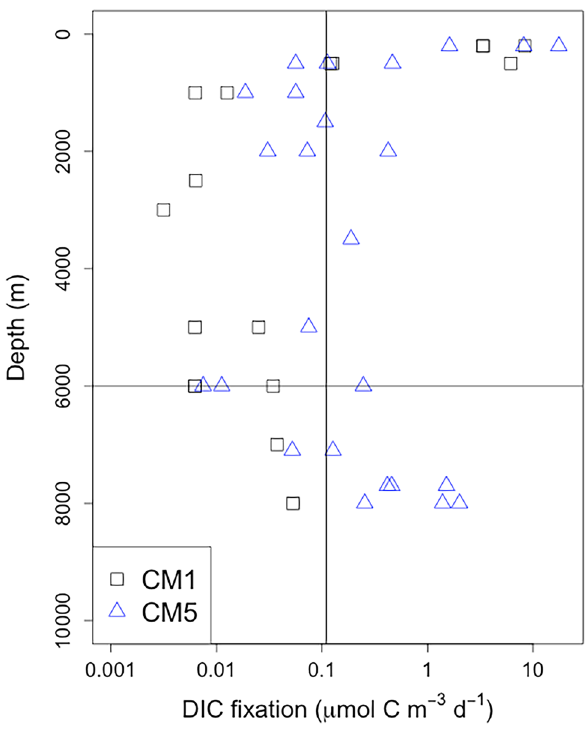
Figure 3. Vertical profiles of DIC fixation rate. Black squares and blue triangles represent CM1 and CM5, respectively. The horizontal black line represents a depth of 6000 m, and vertical black line represents the detection limit. The detection limit is calculated to be three times the standard deviation of the DPM of blank samples. When the negative values are calculated after the blank corrections, the values are not shown here. Horizontal axis is shown on a logarithmic